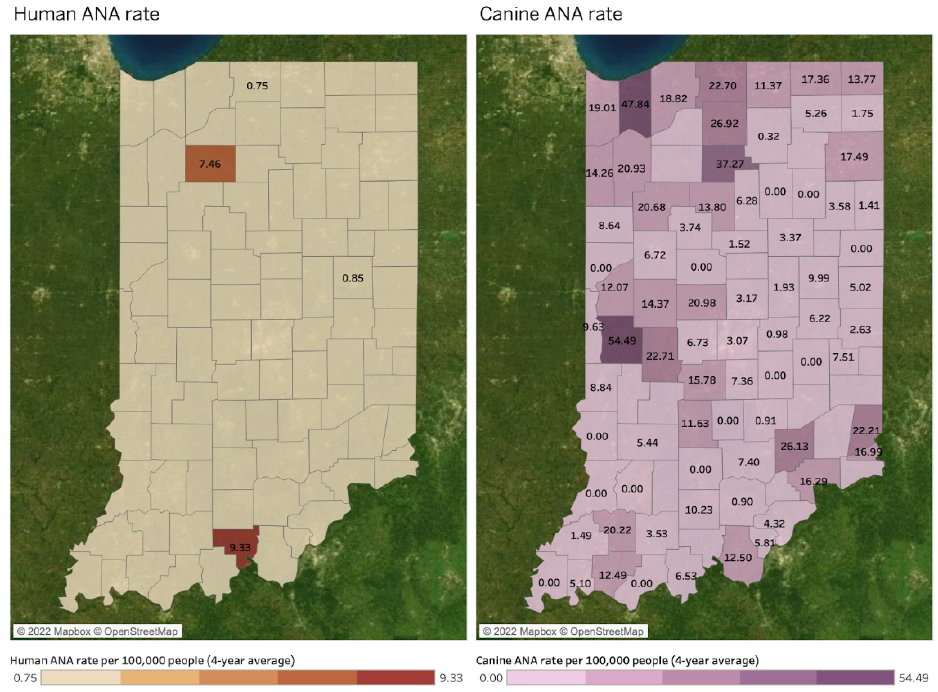
Figure 5. Human and canine ANA rates per 100,000 people by county (4-year average between 2017 and and 2020).